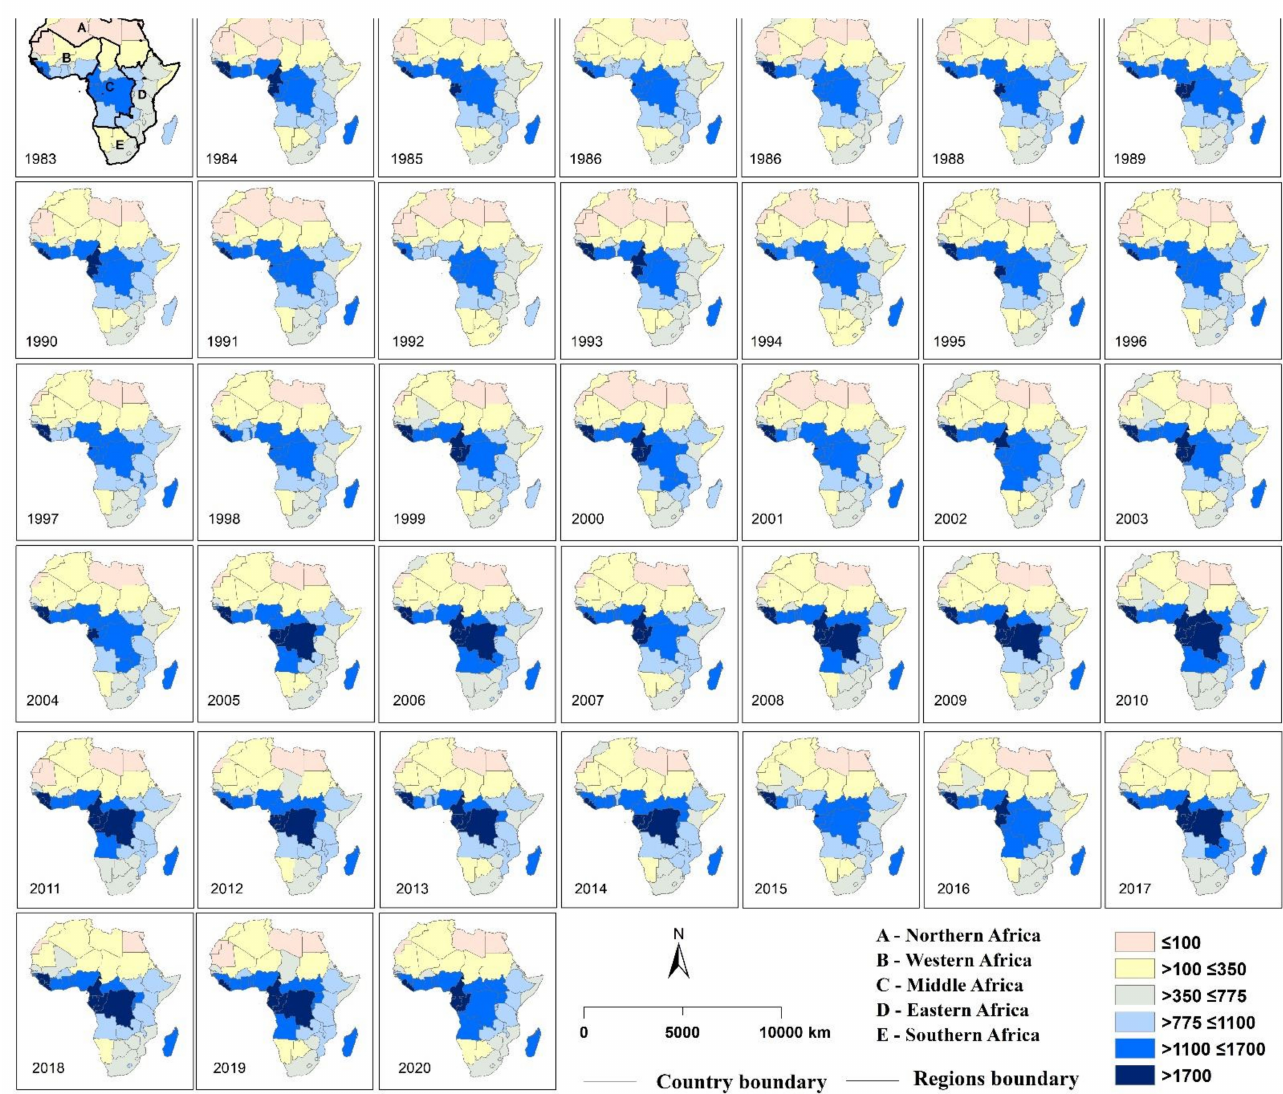
Figure 5. Changes in African countries’ annual average rainfall from 1983 to